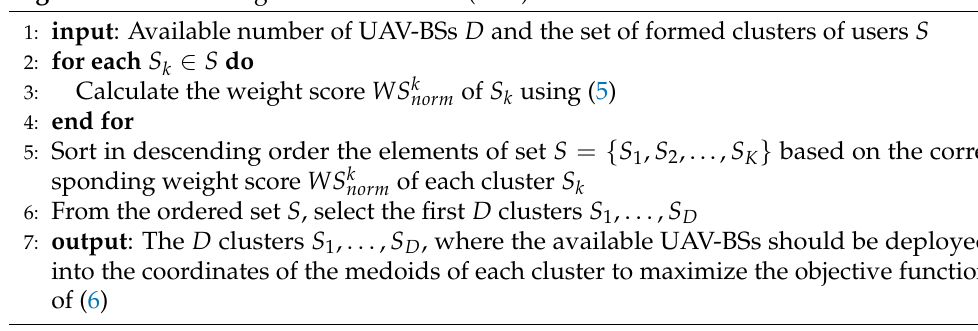
Algorithm 2 Clustering Selection Process